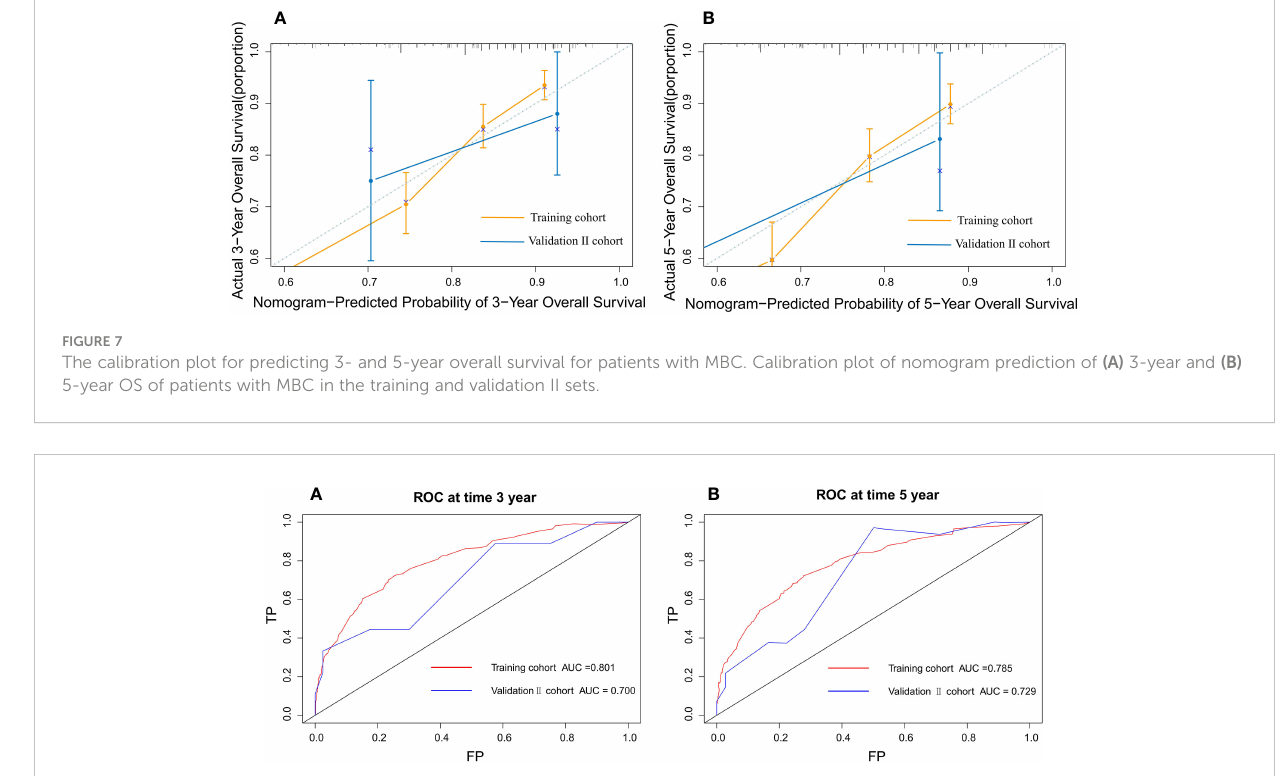
FIGURE 8 Discriminatory accuracy for predicting OS examined by ROC analysis calculating AUC. There-year OS in the training and validation II sets (A) . Five- year OS in the training and validation II sets (B) .